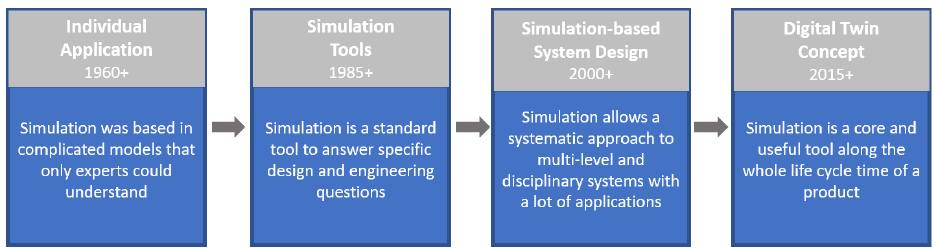
Figure 2. The evolution of simulation along time (Adaptable from Rosen et al.